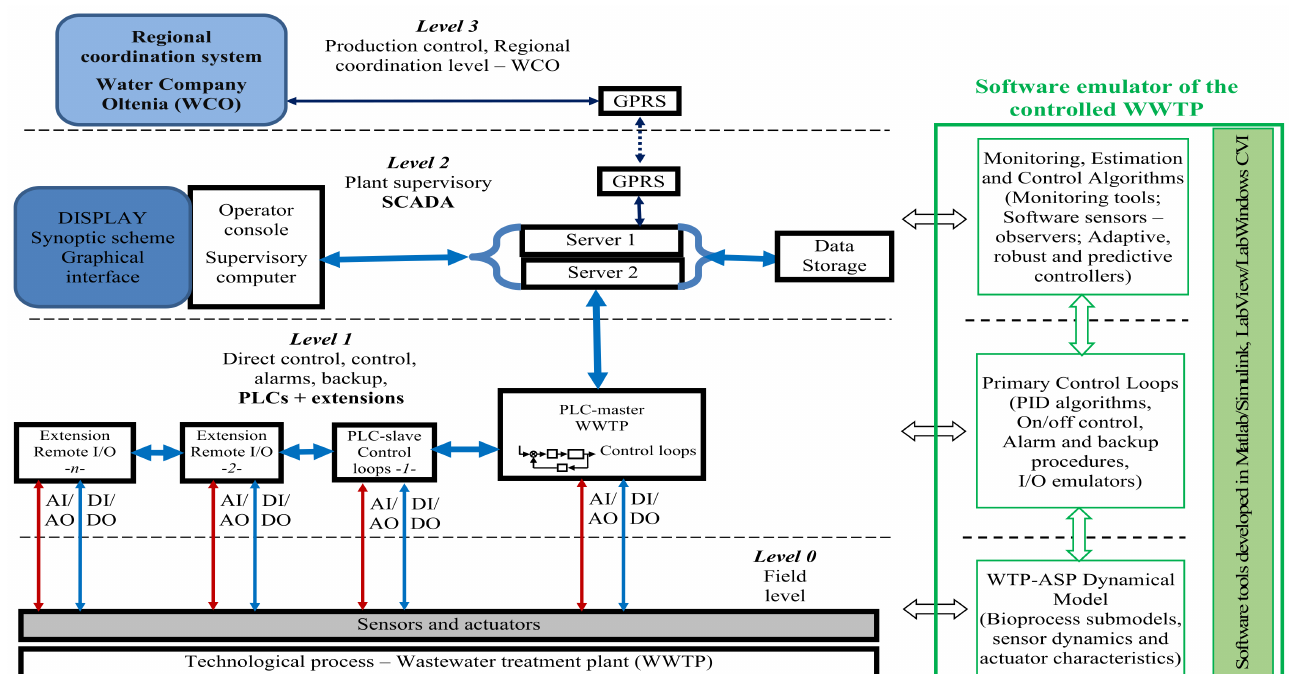
Figure 1. The distributed control system/SCADA architecture of a WWTP and the simulator of the controlled plant (WWTP F ă c ă i, Romania)